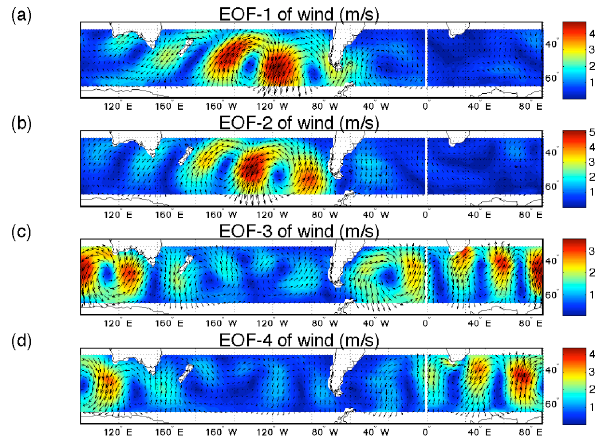
Figure 4. Leading EOFs of SLW: (a,b) EOFs 1 and 2; (c,d) EOFs 3 and 4. 2 Fig. 4. Leading EOFs of SLW: (a, b) EOFs 1 and 2; (c, d) EOFs 3 and 4.